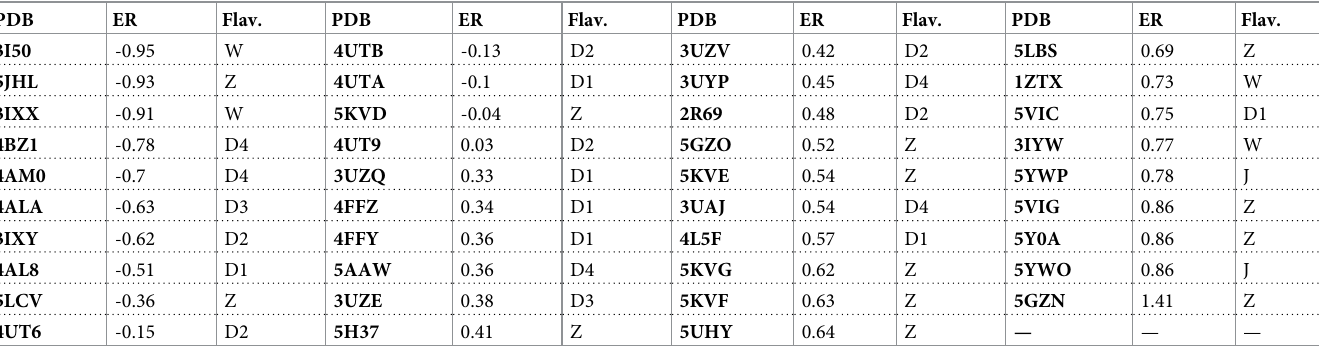
Table 4. Flavivirus epitope mean evolutionary rates.